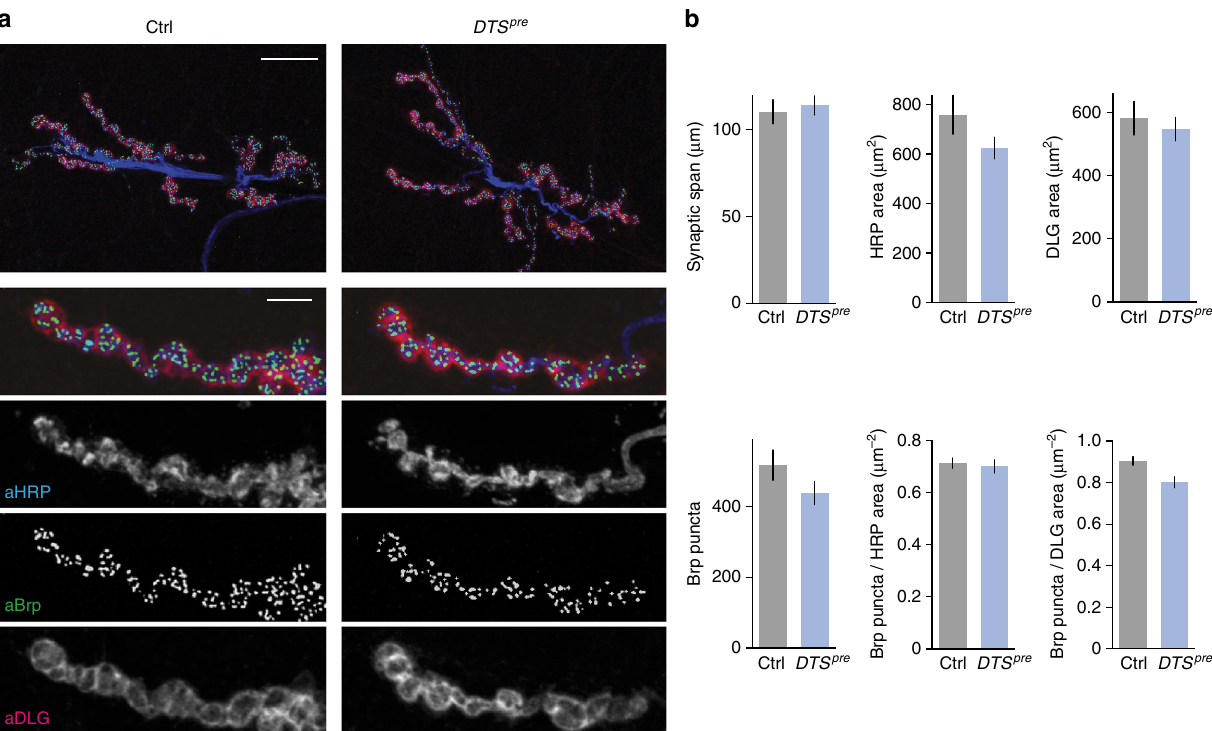
Fig. 3 Presynaptic overexpression of the mutant proteasome subunit DTS does not induce apparent changes in synapse morphology. a Immunostainings of a control NMJ ( elav C155 -Gal4 ) and an NMJ expressing two copies of the mutant proteasome subunit DTS5 presynaptically ( elav C155 -Gal4;UAS-DTS5 ; ‘ DTS pre ’ ). Larvae were kept at the permissive temperature (25 °C) throughout development. NMJs were stained for neuronal membrane (aHRP), postsynaptic reticulum (aDLG) and the active zone marker Bruchpilot (aBrp); scale bar overview = 20 µ m; scale bar inset = 5 µ m. b Quanti fi cation of NMJ parameters for the two genotypes shown in ( a ). Presynaptic DTS overexpression does not result in apparent changes in synapse morphology. Mean ± s.e. m.; n = 24 NMJs; Student ’ s t